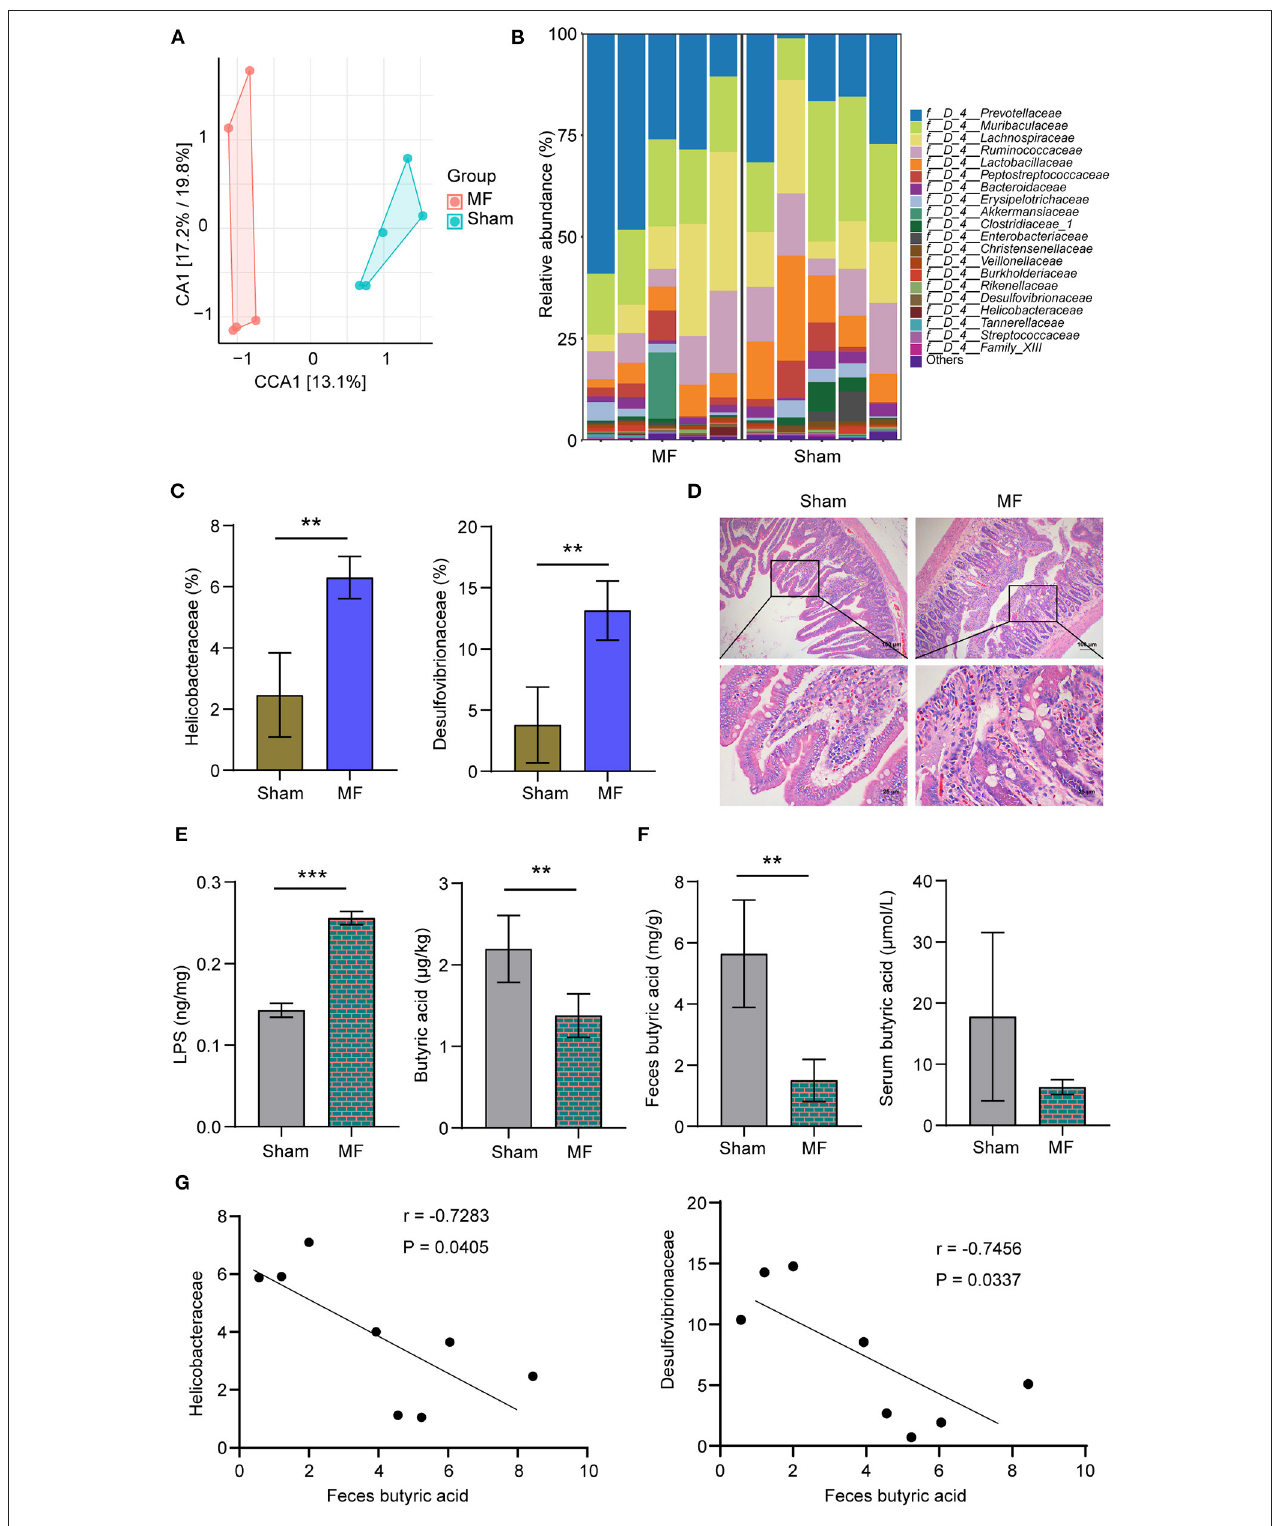
FIGURE 2 | The content of butyric acid was decreased in the MF group. (A) PCA of bacterial community distribution. (B) Histogram of the relative abundance of top 20 ASVs at the Family level. (C) The abundance of Desulfovibrionaceae and Helicobacteraceae . (D) HE staining of the gut ( × 100, 100 µ m; × 400, 25 µ m). (E) LPS and butyric acid levels in the plasma. (F) HPLC detection of butyric acid content in the feces and serum. (G) Pearson correlation coefficient analysis between feces butyric acid and Helicobacteraceae or Desulfovibrionaceae . ** P < 0.01, *** P < 0.001.